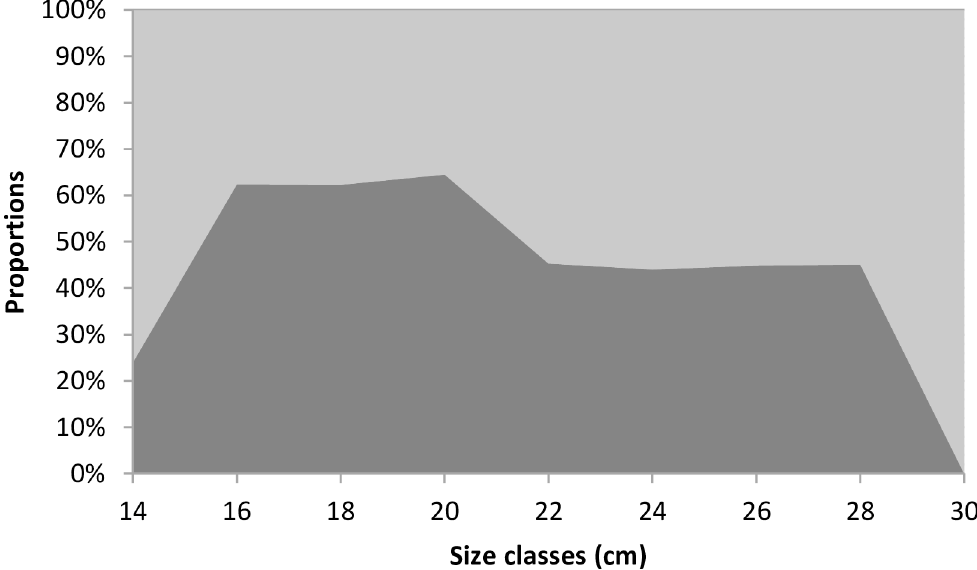
Fig 7. Female (light grey) and male (dark grey) Sardinella maderensis sex ratio in 2 cm size classes. Sizes are represented by the fork length.